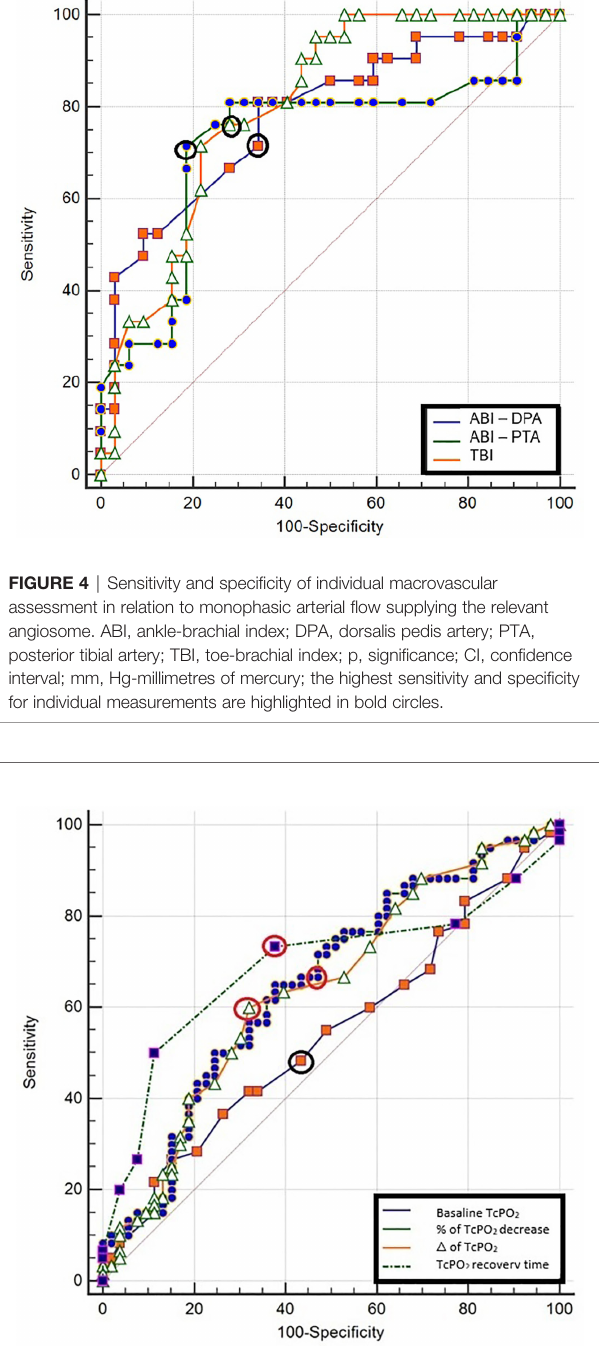
FIGURE 5 | Sensitivity and speci fi city of microvascular assessment and TcPO2 stimulation parameters in relation to monophasic arterial fl ow supplying the relevant angiosome. TcPO2, transcutaneous oxygen measurement; △ -difference of TcPO2 counted as resting TcPO2 minus minimal TcPO2 detected during the stimulation test; %-percentage; p- signi fi cance; CI, con fi dence interval; mmHg, millimetres of mercury; the highest sensitivity and speci fi city for individual measurements are highlighted in bold